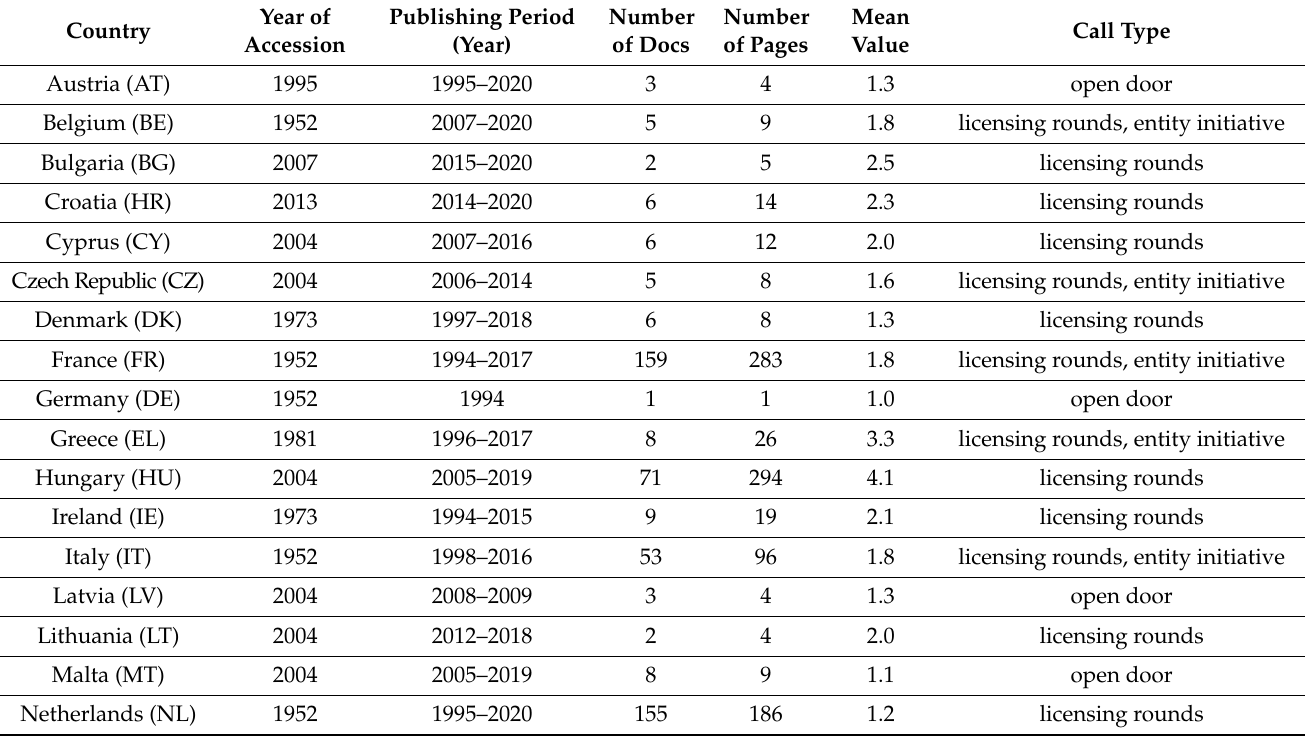
Table 1. Basic information on countries publishing calls in context of the Hydrocarbons